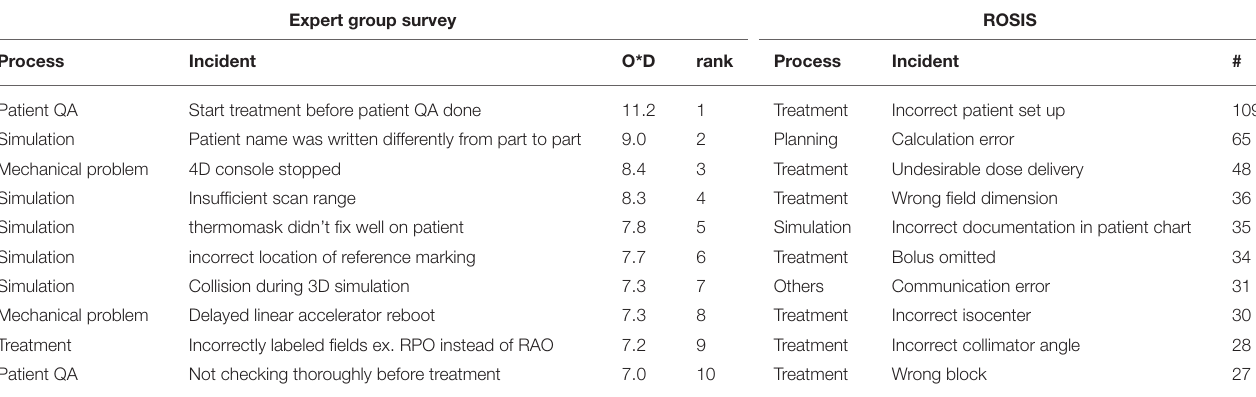
TABLE 2 | Items ranked in the top 10 in expert group survey (O * D) and ROSIS. Expert group